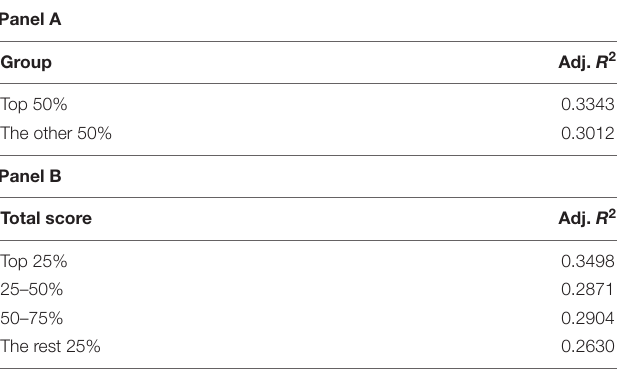
TABLE 7 | MCD disclosure and value relevance of financial